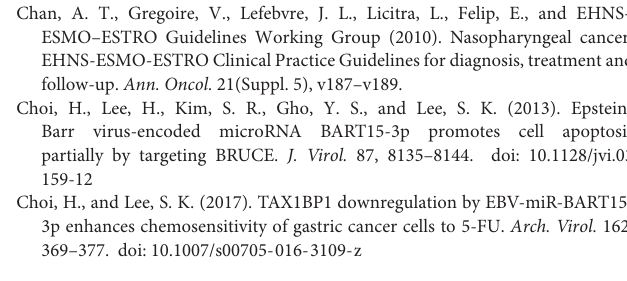
Supplementary Figure 1 | The performance of our 6-miRNA prognostic model to predict OS in different age group. (A) The AUCs of our 6-miRNA prognostic model to predict OS in age ≤ 54 and age > 54. (B) Compare the AUCs of our 6-miRNA prognostic model to predict OS in different age group. The dash lines represent pointwise confidence intervals. Supplementary Figure 2 | The 6-miRNA risk score was an independent predictor for OS, DFS, and MFS. Multivariate Cox analysis evaluating independently predictive ability of 6-miRNA risk score and other clinical risk factors for OS, DFS, and MFS using 558 NPC patients. The square data markers indicate estimated hazard ratios. The error bars represent 95% CIs. OS: overall survival; DFS: disease-free survival; MFS: metastasis-free survival. Supplementary Table 1 | Target genes of the prognostic